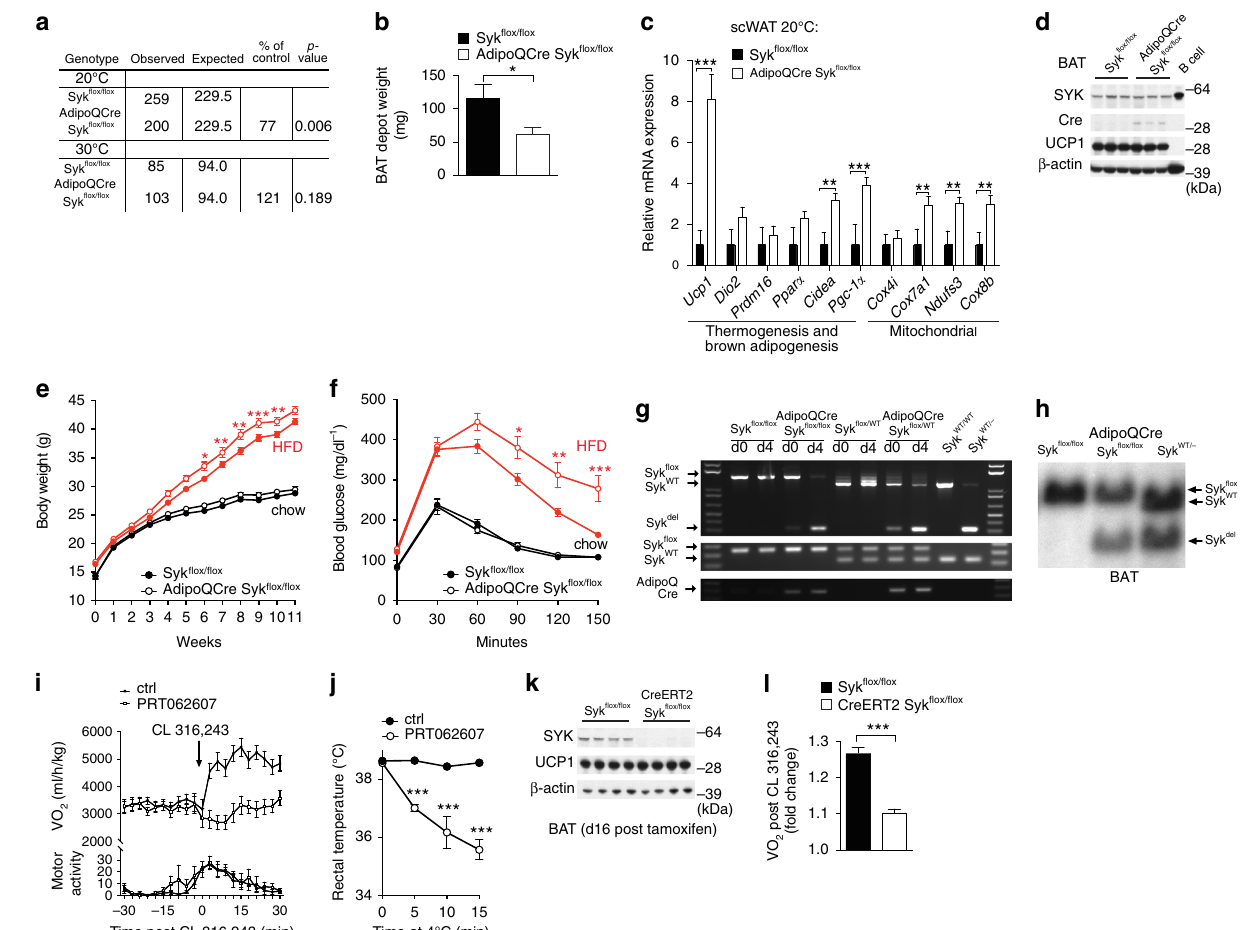
Fig. 4 SYK de fi ciency is incompatible with brown fat formation and activation. Genotypes of offspring at weaning age from AdipoQCre Syk fl ox/ fl ox mice mated with Syk fl ox/ fl ox mice ( a ). Weight of complete BAT depots from 4 week old mice ( n = 5 each genotype) on a chow diet ( b ). c RNA expression in subcutaneous white adipose tissue scWAT (AdipoQCre Syk fl ox/ fl ox , n = 5; Syk fl ox/ fl ox , n = 4) and representative immunoblots ( d ) of BAT ( n = 3) from 7 – 8 week old mice on a chow diet housed at 20 °C. Body weights ( e ) and glucose tolerance test ( f ) of AdipoQCre Syk fl ox/ fl ox mice or Syk fl ox/ fl ox mice on a high fat diet (HFD) in red (AdipoQCre Syk fl ox/ fl ox , n = 17; Syk fl ox/ fl ox n = 18,) and chow diet (chow) in black (AdipoQCre Syk fl ox/ fl ox , n = 15; Syk fl ox/ fl ox , n = 21). Asterisks shown are multiple hypothesis corrected p values < 0.05 for an unpaired two-tailed t test of weights ( e ) or blood glucose ( f ) per time point. PCR ampli fi cation ( g ) of the deleted Syk fl ox allele (top), Syk fl ox genotype (middle) and the AdipoQCre allele (bottom) in brown pre-adipocytes (d0) and differentiated brown adipocytes (d4) derived from BAT of the indicated genotype and heterozygous germline deleted mice. h Southern blot of BamHI digested genomic DNA of BAT from 6 weeks old mice with the indicated genotypes. i Oxygen consumption (upper panel) and motor activity (lower panel) before and after intraperitoneal (i.p.) injection of CL316,243 with ( n = 13, female mice) or without SYK-i4 (PRT 062607) ( n = 13, female mice). j Core body temperature after acute cold exposure with or without i.p. injected SYK inhibitor PRT 062607 ( n = 5). k Immunoblotting of BAT from 10 week old CreERT2 Syk fl ox/ fl ox mice and Syk fl ox/ fl ox controls ( n = 4, male mice) 16 days after last tamoxifen treatment. l Oxygen consumption measured (VO 2 ) during the sleep cycle was compared with VO 2 measured for 12 h post injection with CL316,243 subcutaneous (s.c.) of the mice shown in k ( n = 4). For i – j , l P values were calculated with the two-way ANOVA test. For a , P values were determined using a two-tailed chi-square test, ( b ) data are shown as mean ± SEM, asterisks denote statistical signi fi cance ( p < 0.05) determined by two-tailed t test and for c , asterisks denote statistical signi fi cance ( p < 0.05) determined by